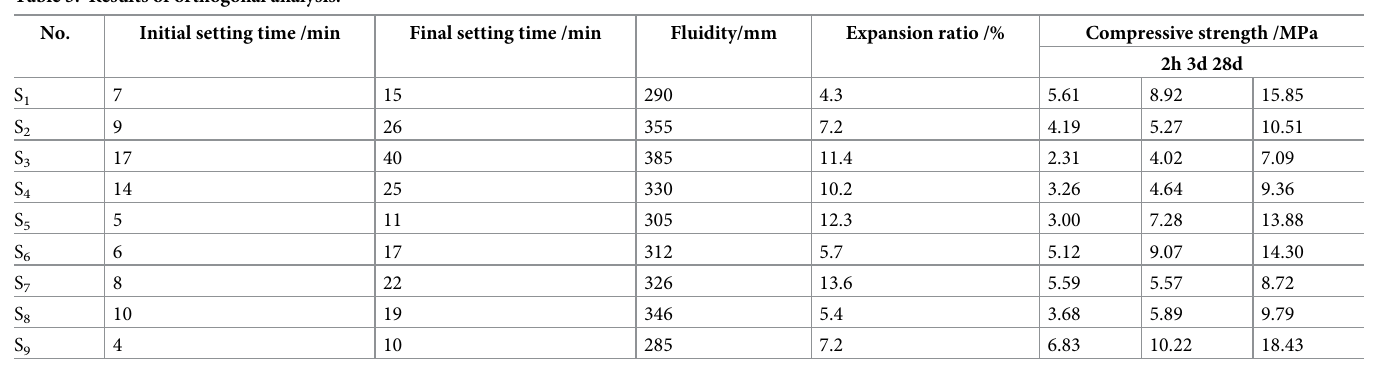
Table 3. Results of orthogonal analysis.